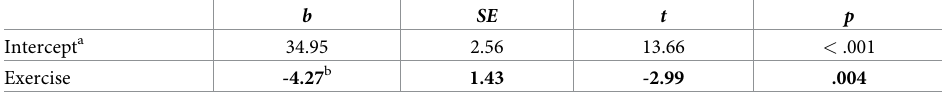
Table 2. Exercise as a predictor of the percentage of unhealthy meals in a day (Study 1). b